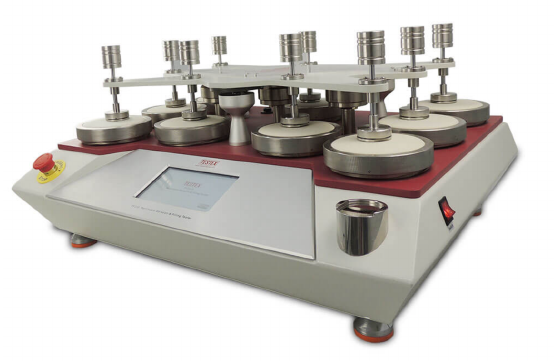
Figure 1. Martindale Abrasion and Pilling Tester TF210